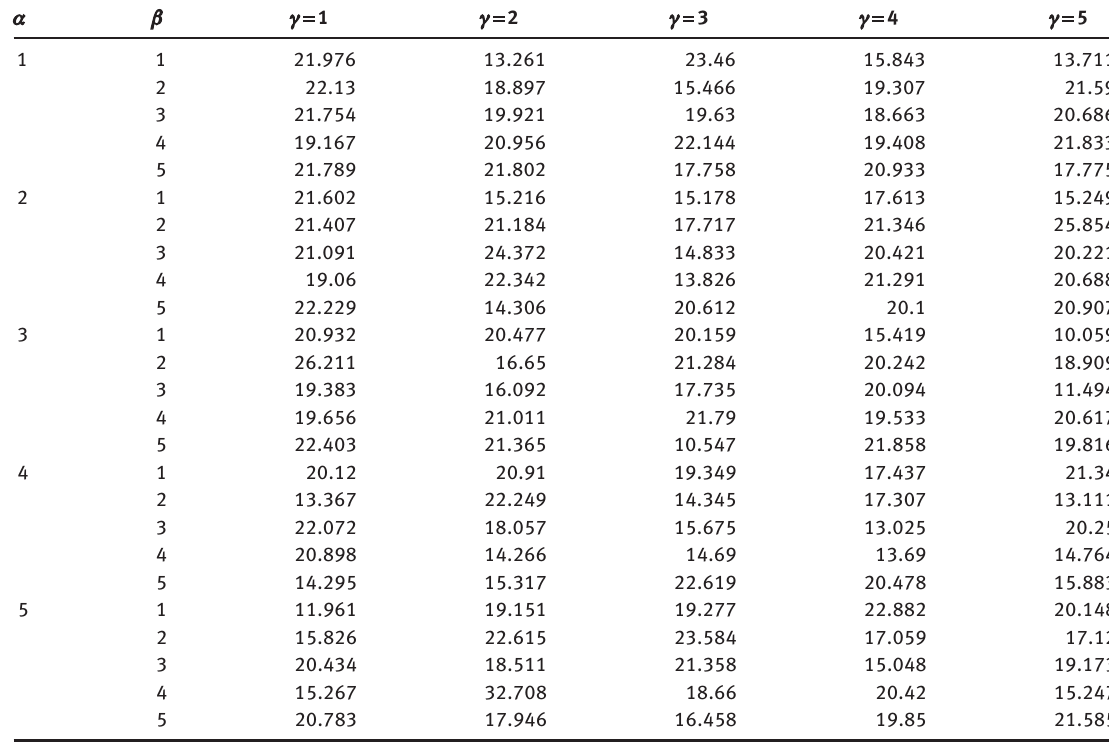
Table 2: Parameters used in Electric Power under Varying β and γ with the Reference of α .